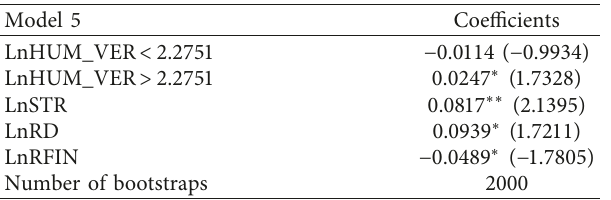
Table 8: Impact of voluntary consciousness environmental reg- ulation on the